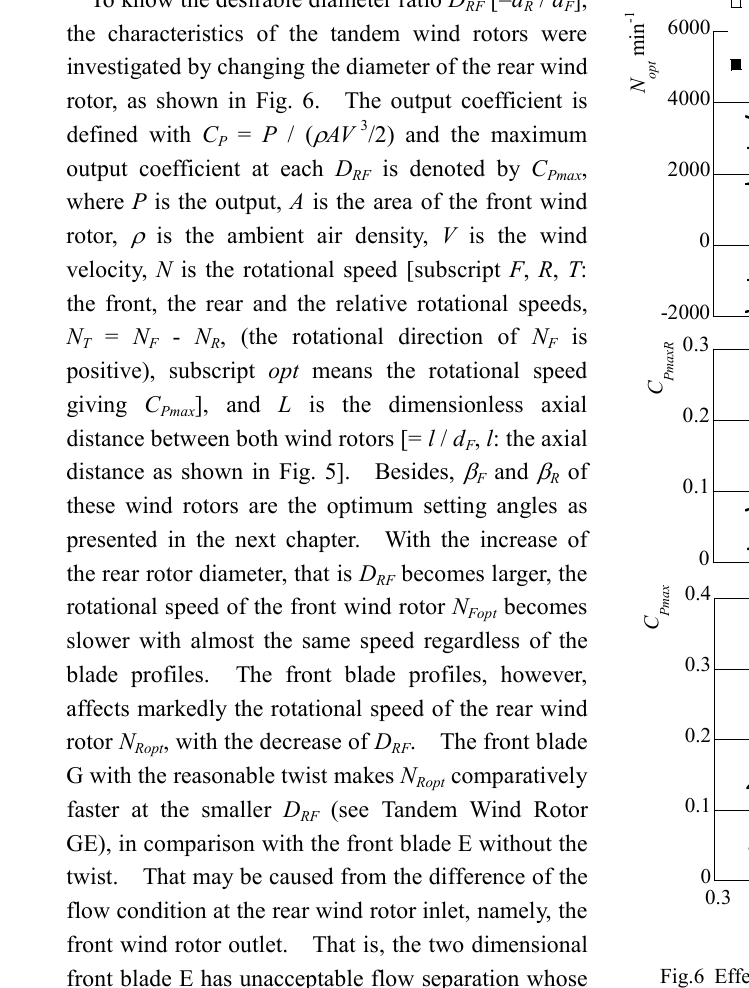
(b) Tandem Wind Rotor GE (a) Tandem Wind Rotor